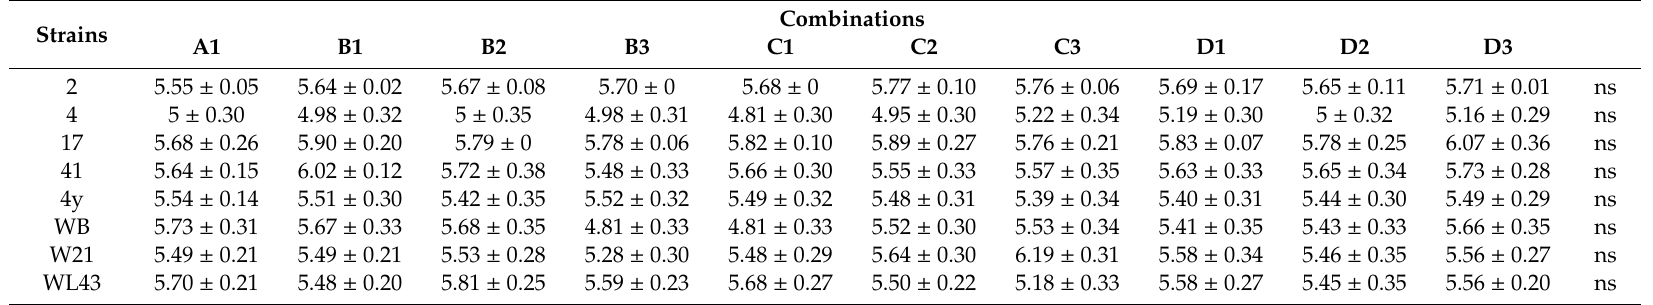
Table 2. Viable count (log CFU / mL) of US-treated Saccharomyces cerevisiae strains, compared to the control (untreated microorganism, A1). Mean values ± standard deviation. ns, for each strain the di ff erences were not significant (one-way ANOVA and Tukey’s test, p > 0.05).